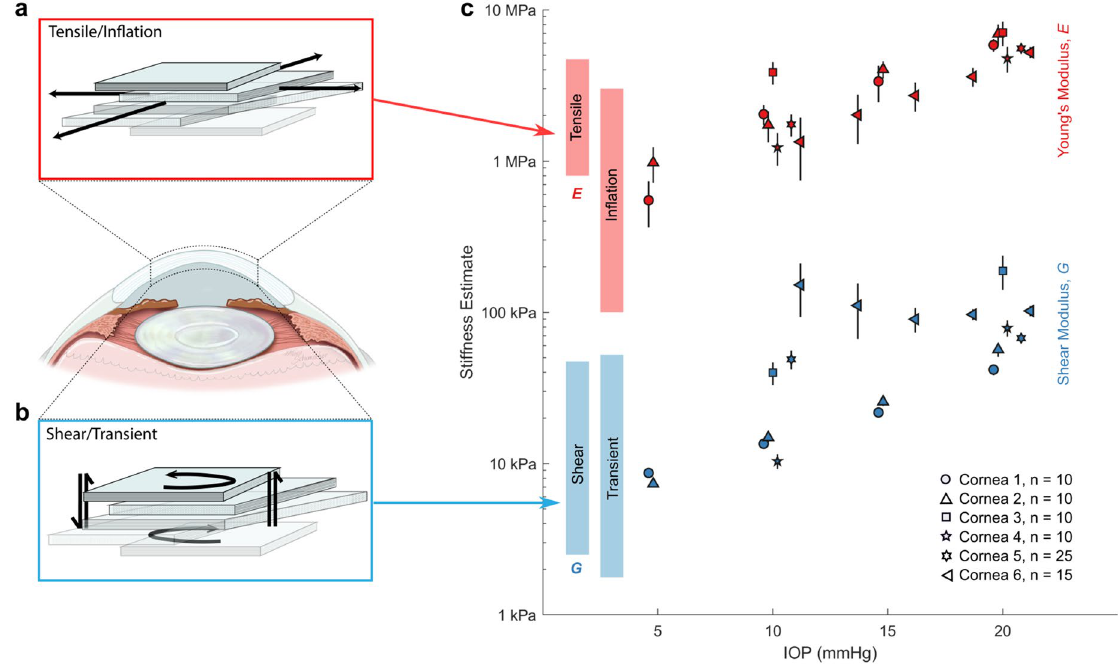
Figure 6. NITI elastic moduli estimates ( G and μ) obtained from AμT-OCE measurements of porcine cornea. Corneal mechanical response can be divided into ( a ) tensile/inflation and ( b ) shear/transient, which can differ by orders of magnitude. ( c ) Young’s modulus (red markers) and shear modulus (blue markers) estimates were obtained from the NITI model for all porcine corneas over a range of IOP. Marker shape corresponds to six individual porcine corneas. For each cornea sample, 10–25 independent scans were taken at each pressure to minimize system variation. Markers denote the mean modulus estimate from repeated OCE measurements on the same cornea, and error bars denote ± one standard deviation. Modulus estimates correspond closely to the range of values reported in the literature for static inflation/tensile tests (red bars) and shear/transient measurements (blue